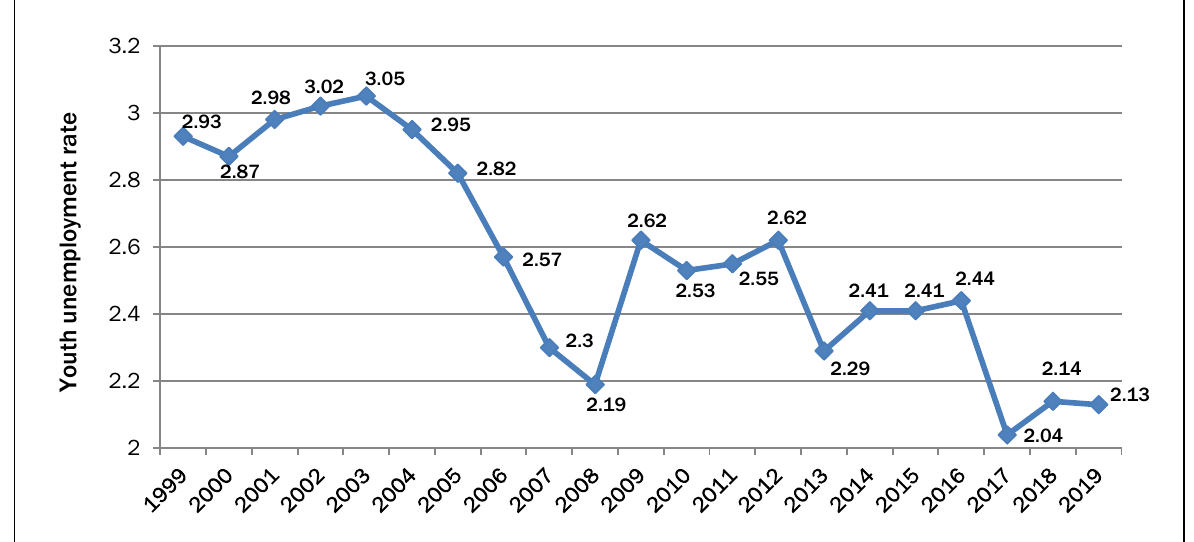
Source: Statistica,